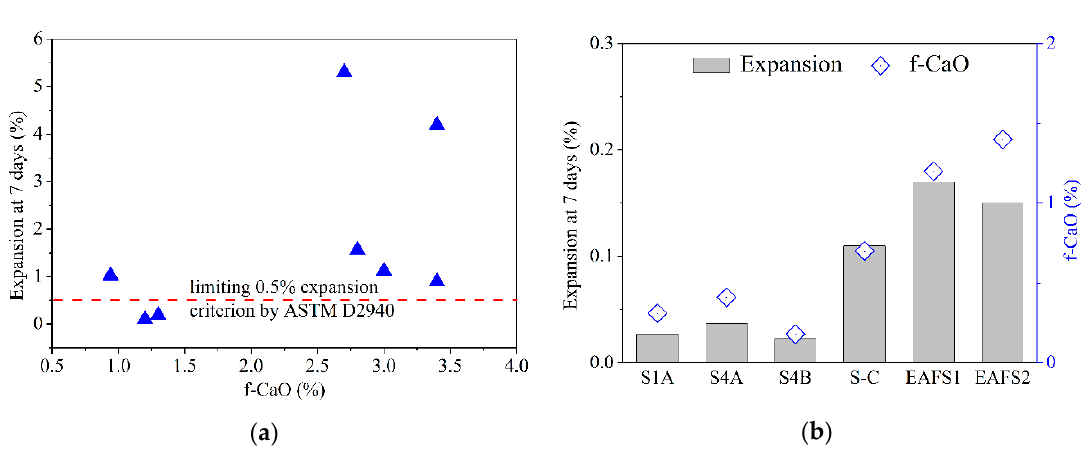
Figure 9. The content of f-CaO and volume expansion for various types of slag: ( a ) LFS; ( b ) modified oxidizing slag and EAFS. Table 5. The results of f-CaO and volume expansion for oxidizing slag.